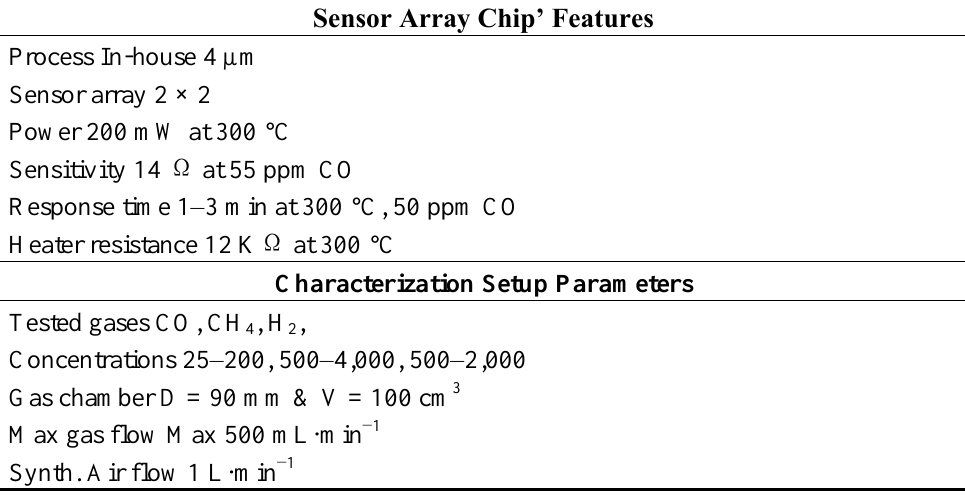
Table 2. Sensor array characteristics and characterization setup